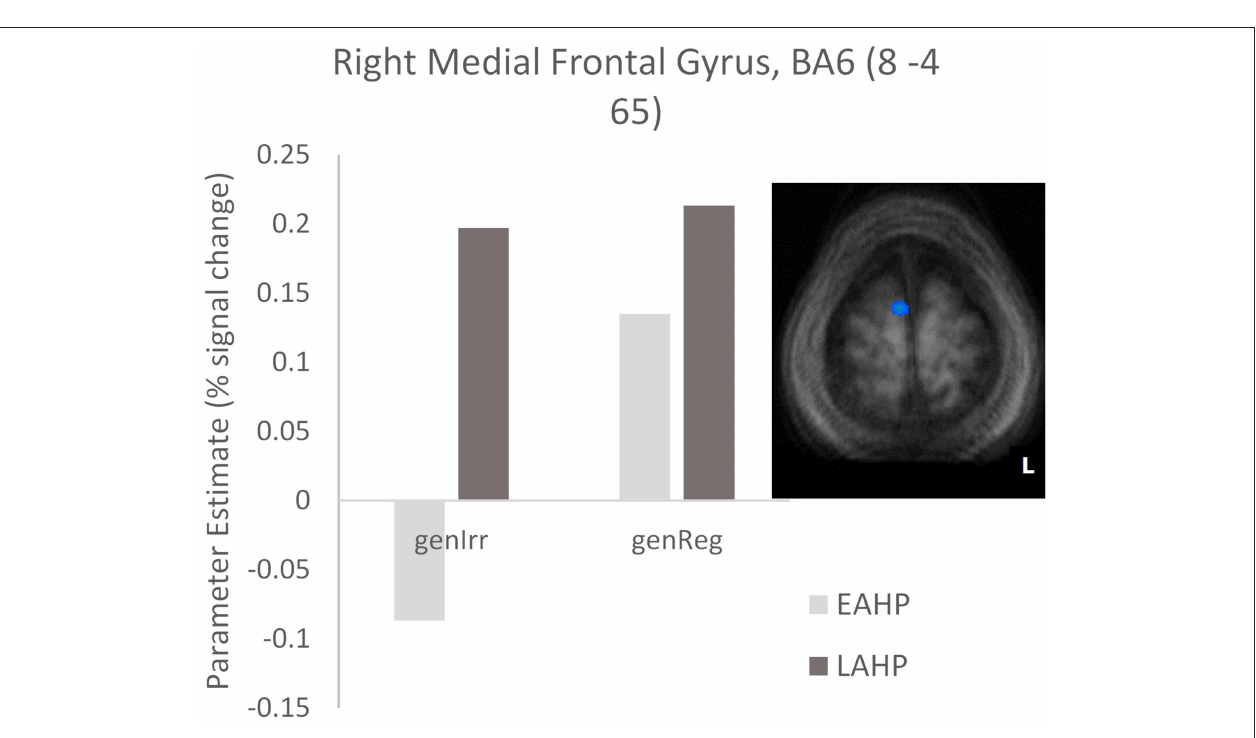
Frontiers in Communication |